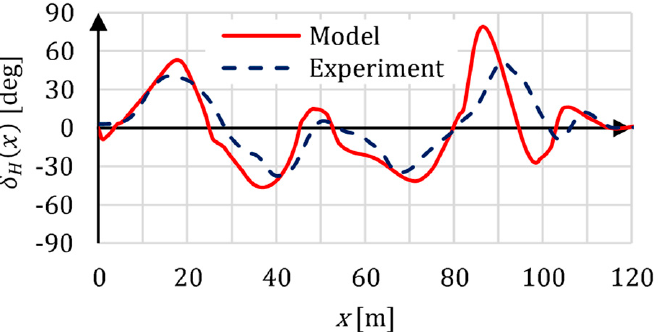
Figure 10. Comparison of the steering wheel angle curves δ H ( x ) obtained in the model tests and experimental tests carried out to validate the CT model. Example comparisons of results of the experimental and simulation tests have been presented in Figure 11.